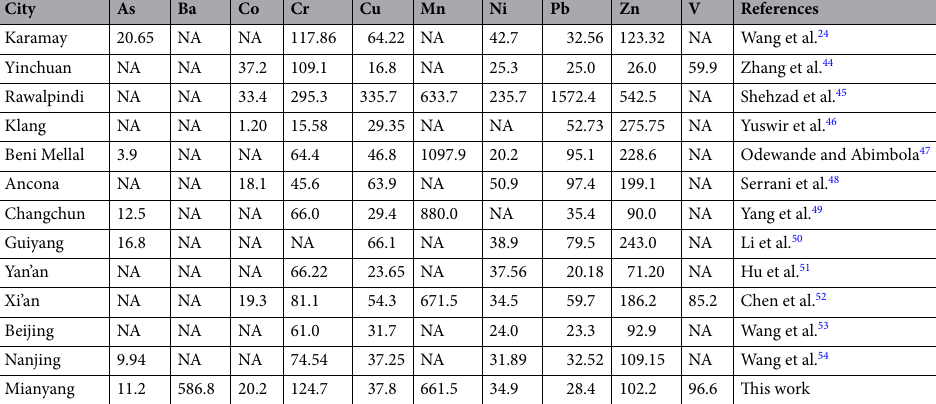
Table 2. Comparative analysis of HM contents (mg kg −1 ) in the topsoil of diverse cities. NA means not